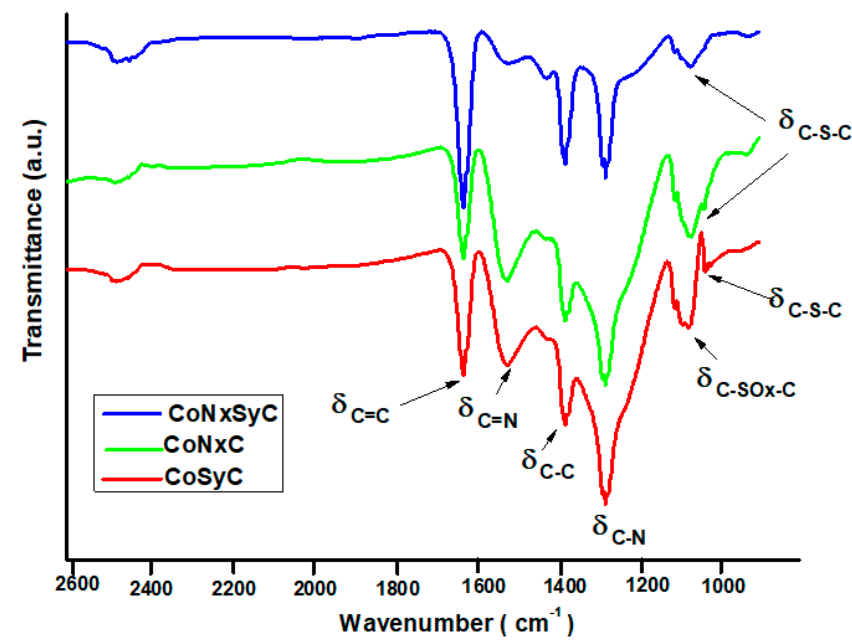
Figure 1. Fourier-transform infrared spectroscopy ( FTIR) spectra of various co-catalysts.